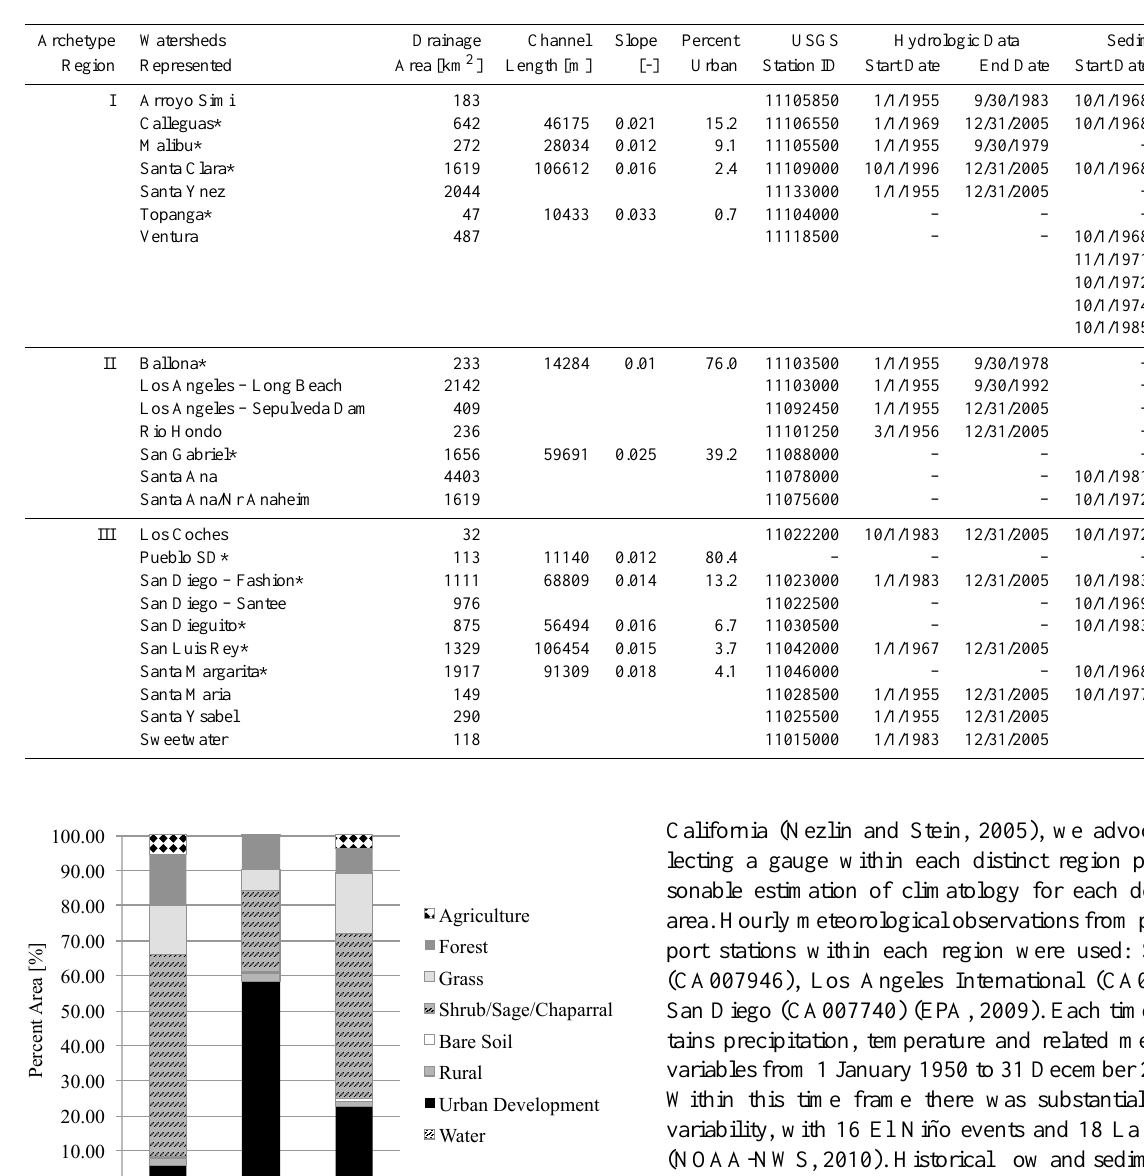
Table 1. Physiographic parameters were obtained for 11 coastal watersheds (*) including drainage area, channel length, slope, land cover (percent urban provided) and reach/channel parameters (NOAA-CSC, 2003). Hydrologic (USGS, 2011) and sediment data (USGS, 2009) were extracted from available watersheds within the archetypal regions.